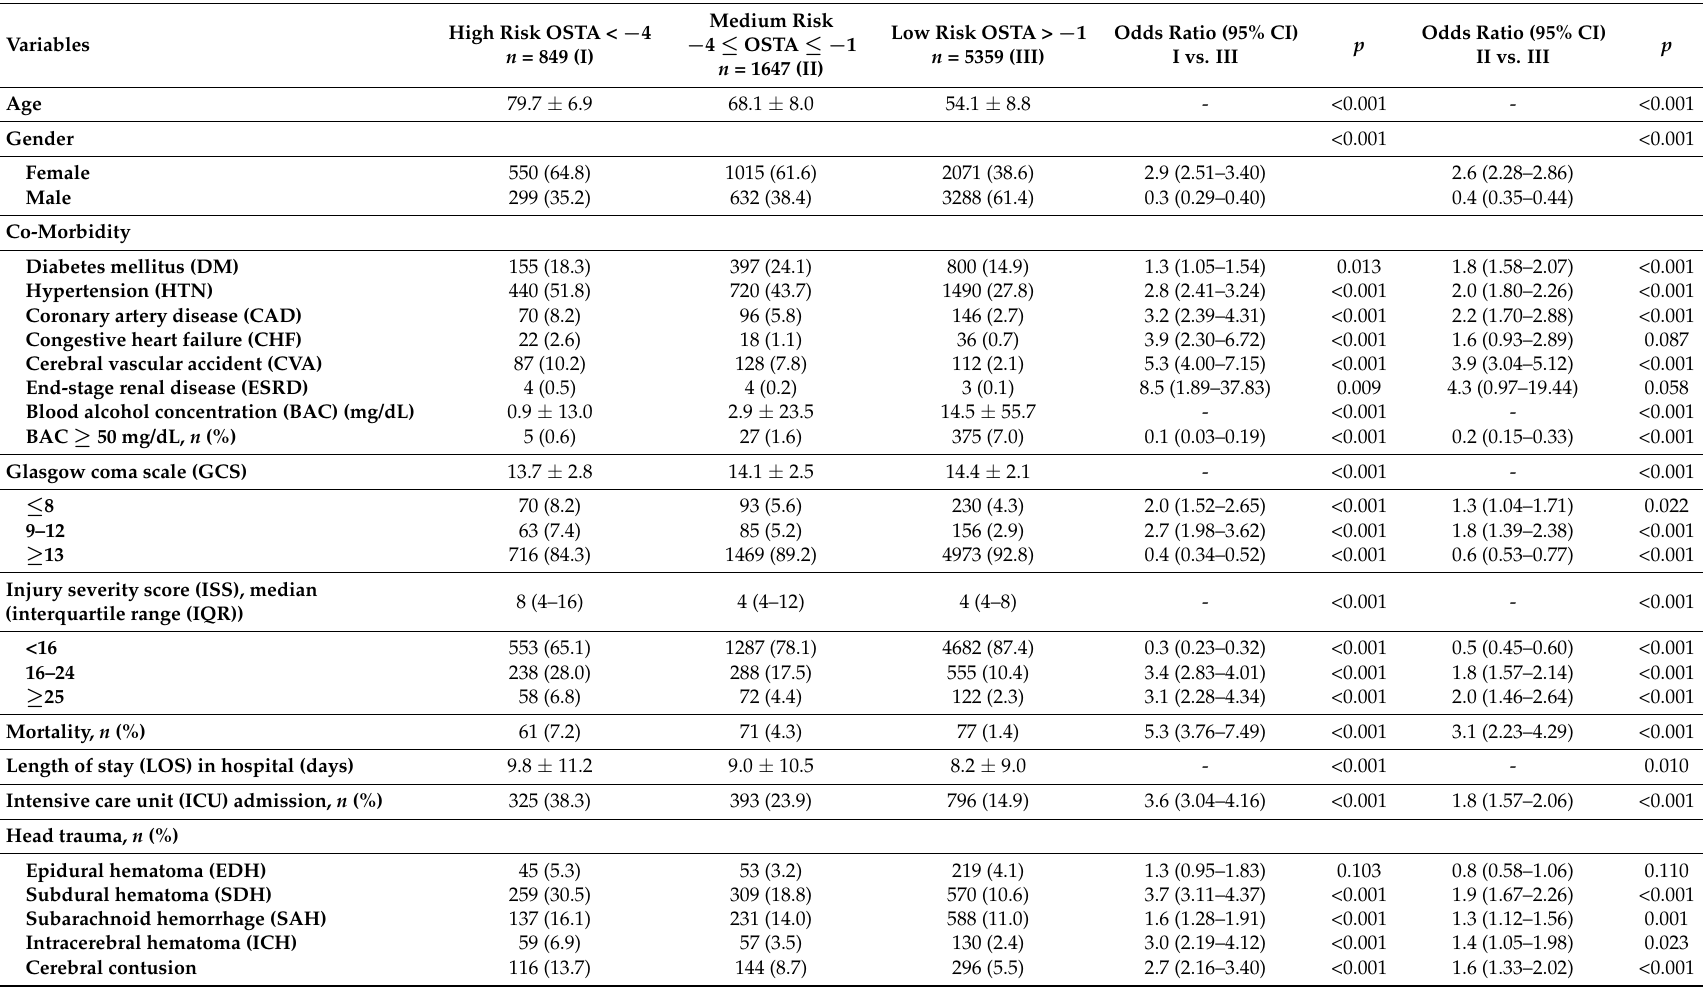
Table 1. Demographics and injury characteristics of high-risk, medium-risk, and low-risk patients with isolated moderate and severe traumatic brain injury (TBI).